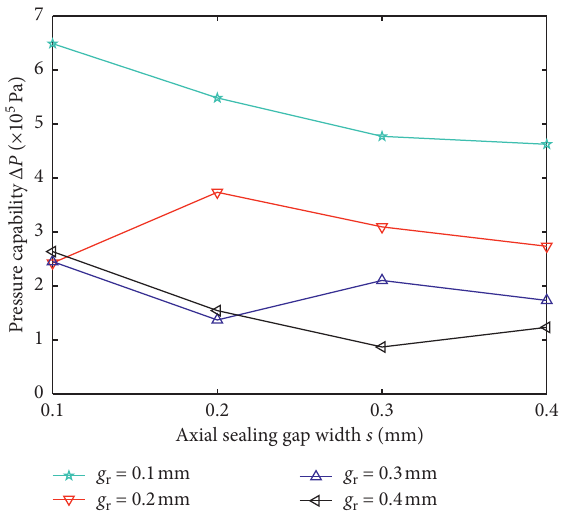
sealing position